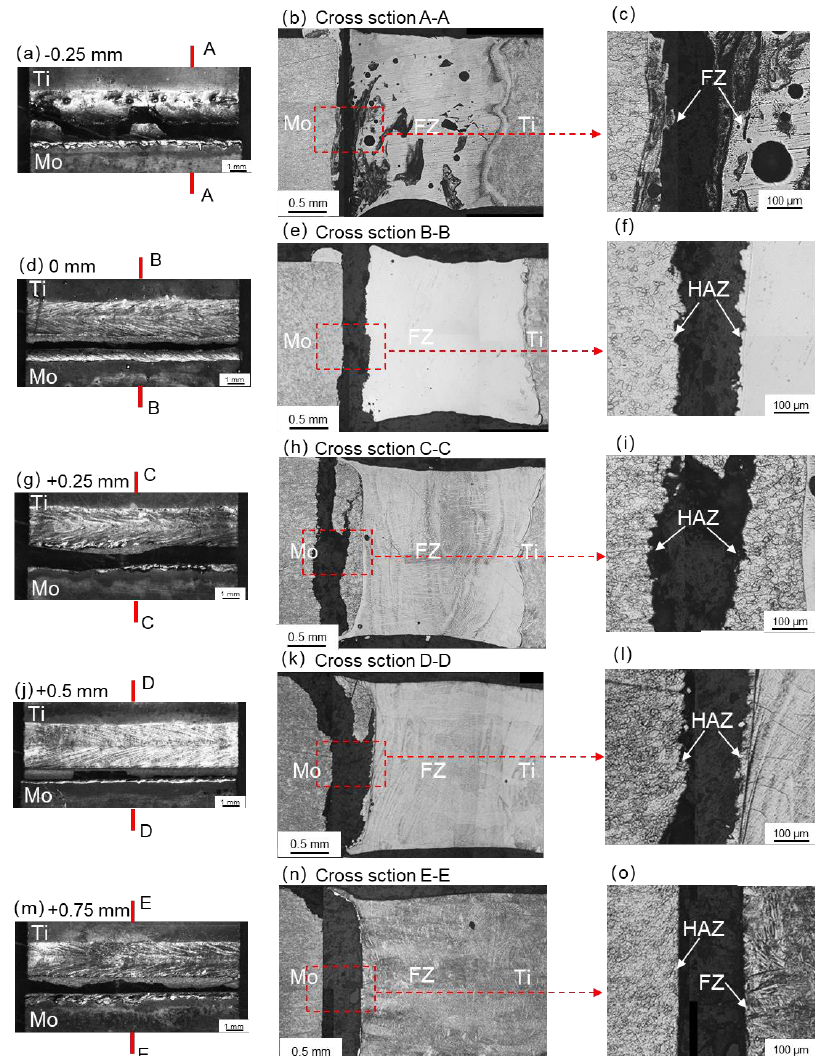
Figure 12. Fracture paths of Mo/Ti joints produced under various laser beam offsets. ( a , d , g , j , m ) top surface morphologies of broken joints; ( b , e , h , k , n ) cross-sectional morphologies of broken joints; ( c , f , i , l , o ) magnified regions in the red boxes in panel b , e , h , k , n respectively.